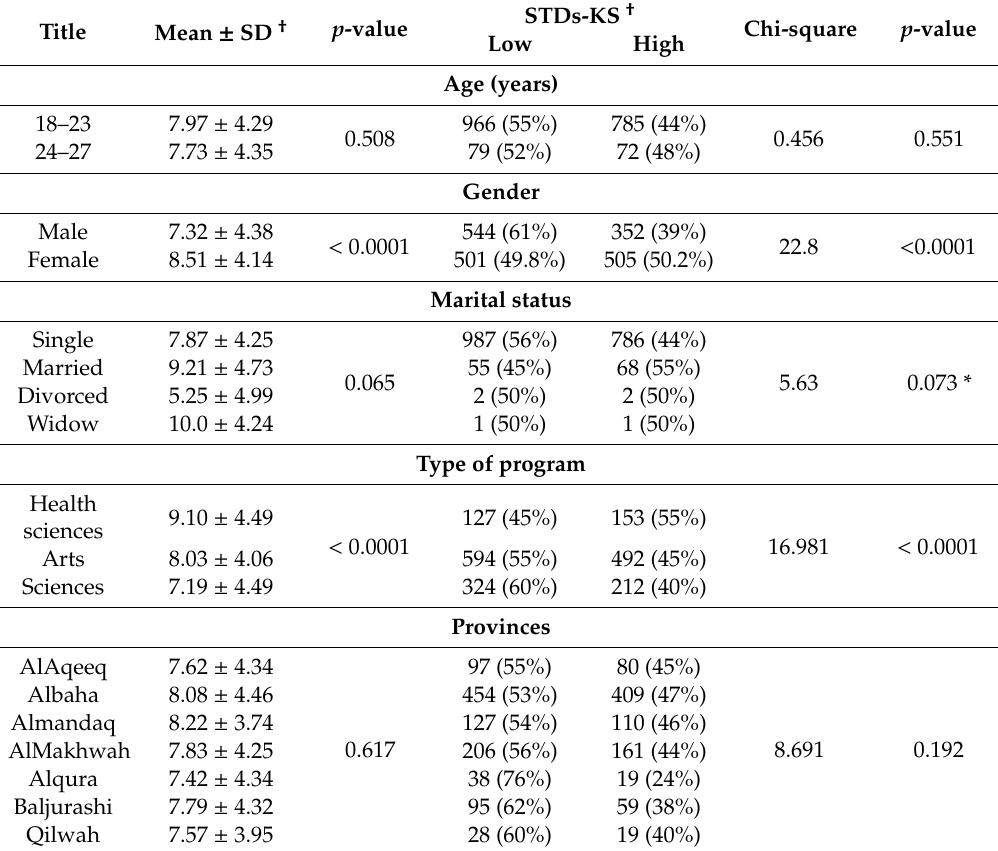
Table 2. Association between sexually transmitted disease knowledge score and demographic characteristics of the